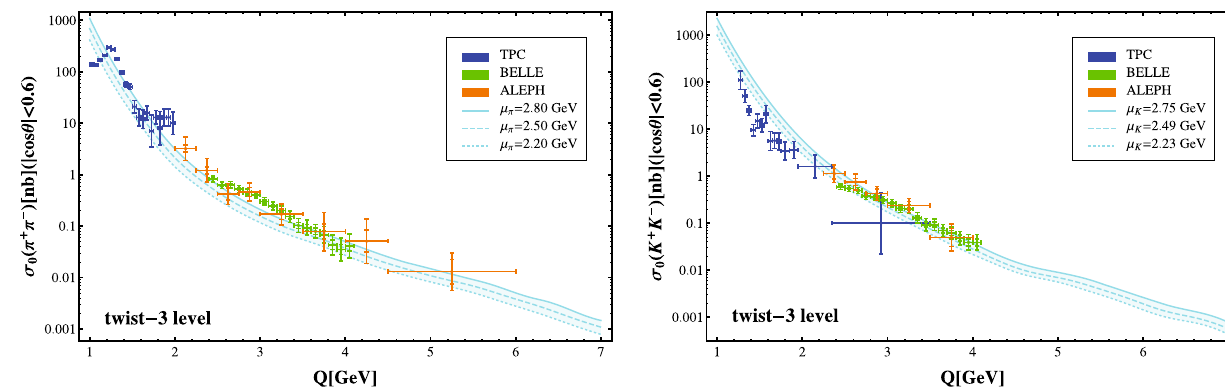
Fig. 4 Twist-3 results of the cross sections σ 0 (π + π − ) and σ 0 ( K + K − ) with uncertainties arising from the chiral enhancement parameters μ M